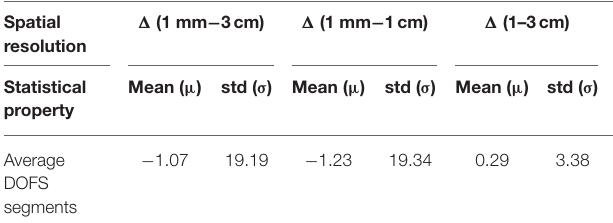
TABLE 1 | Comparison of spatial resolution sets difference [All units represent microstrain ( µε )].